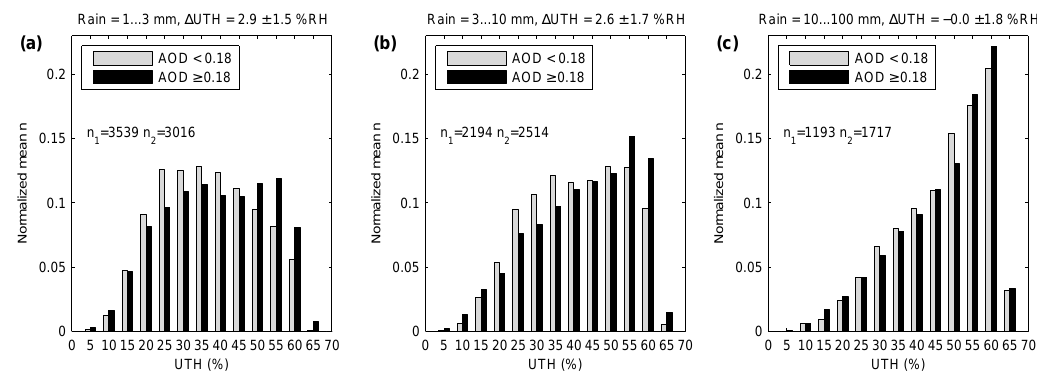
Figure 8. UTH differences in three precipitation categories. Histograms of UTH in case of low and high AOD east of China in June, July and August in 2007–2013, for three categories of daily precipitation: (a) 1–3mm, (b) 3–10mm and (c) 10–100mm. The y axis shows the normalised mean histogram of UTH, which is the mean of 10 precipitation bins in each precipitation category. (cid:49) UTH was calculated as mean of { median[UTH(AOD ≥ 0.18)] − median[UTH(AOD < 0.18)] } , while its 90% confidence interval was calculated from the standard error of the monthly mean. The values are presented as percentage units. n 1 and n 2 show the number of data points in low and high AOD cases, respectively. The cirrus dependence has been removed from the AOD data.